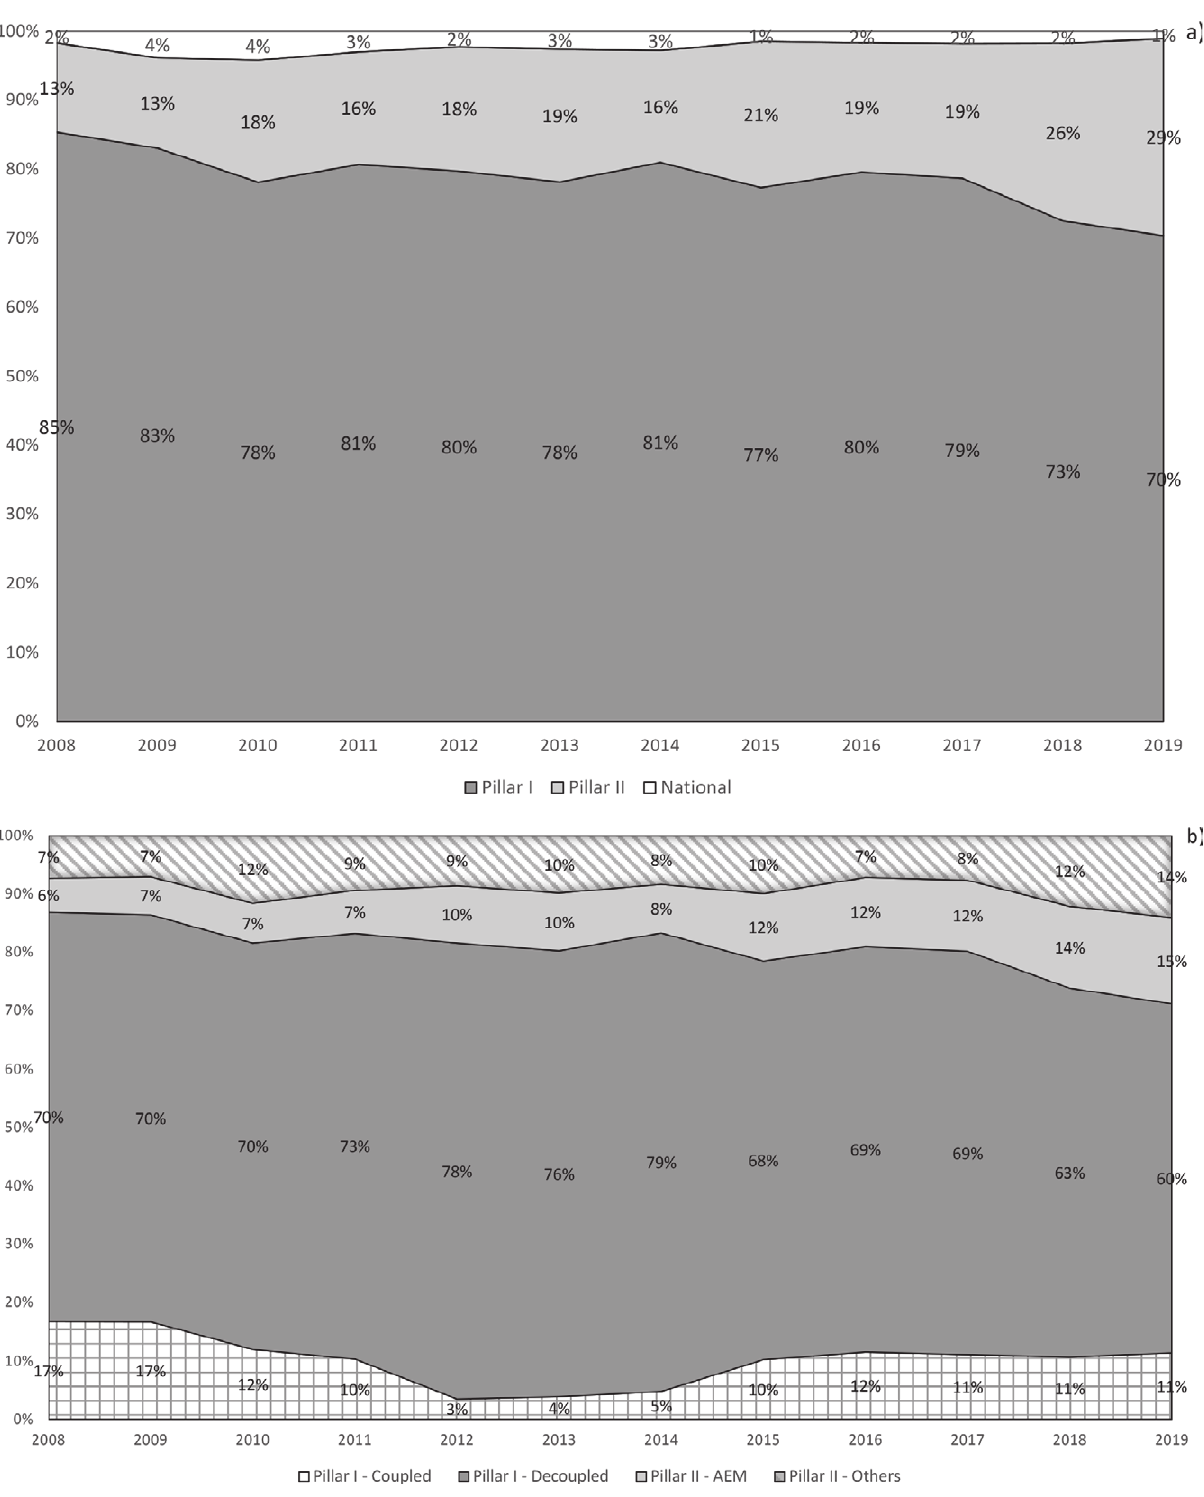
Figure 2. Composition of the total public (a) and CAP (b) support within the Italian 2008-2019 FADN balanced